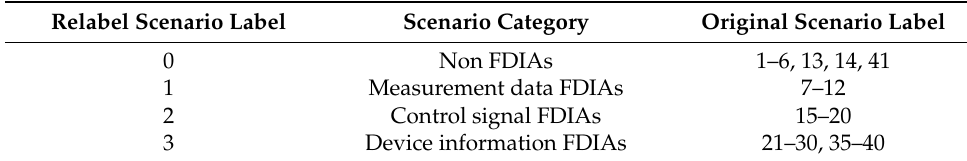
Table 1. Description of 4 types of scenarios after processing and